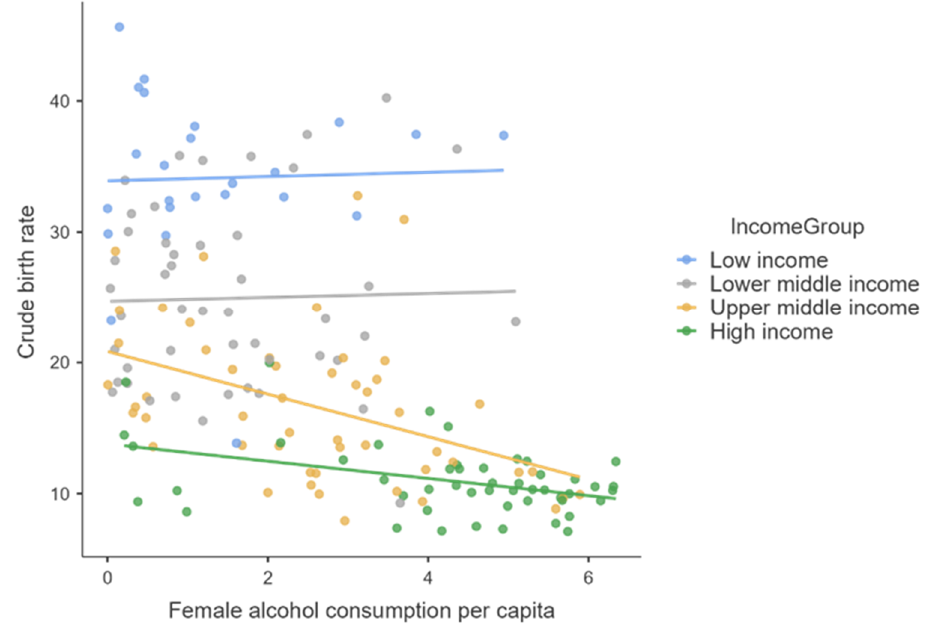
Figure 2. The correlation between female’s alcohol consumption per capita and the crude birth rate .